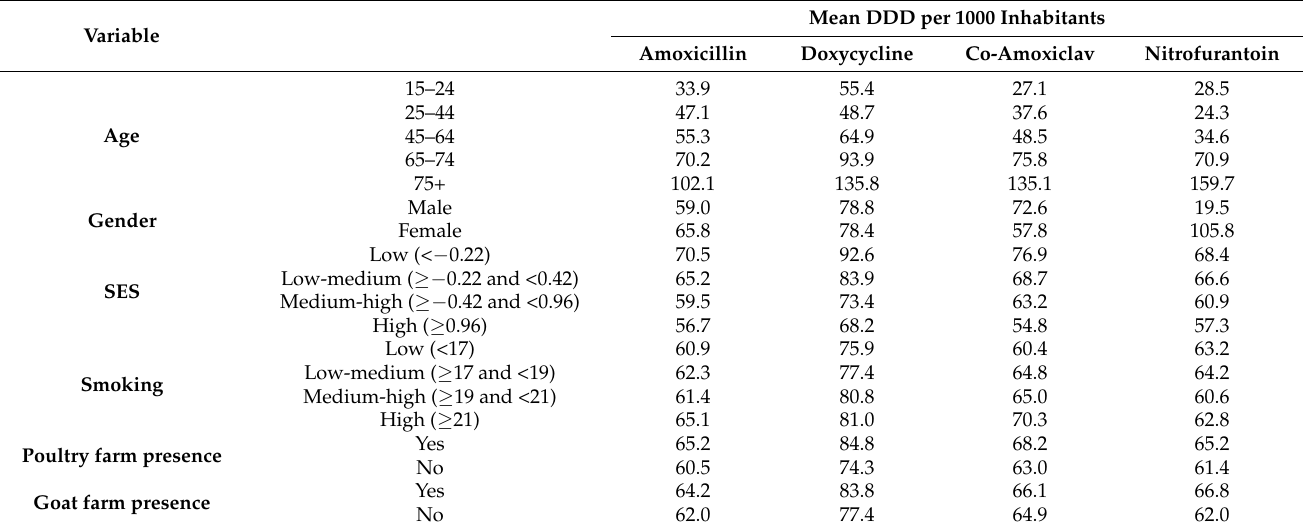
Table 2. Mean DDD per 1000 inhabitants in PC4 areas ( n = 2586) by age group, gender, SES, smoking status, and presence of poultry or goat farms.